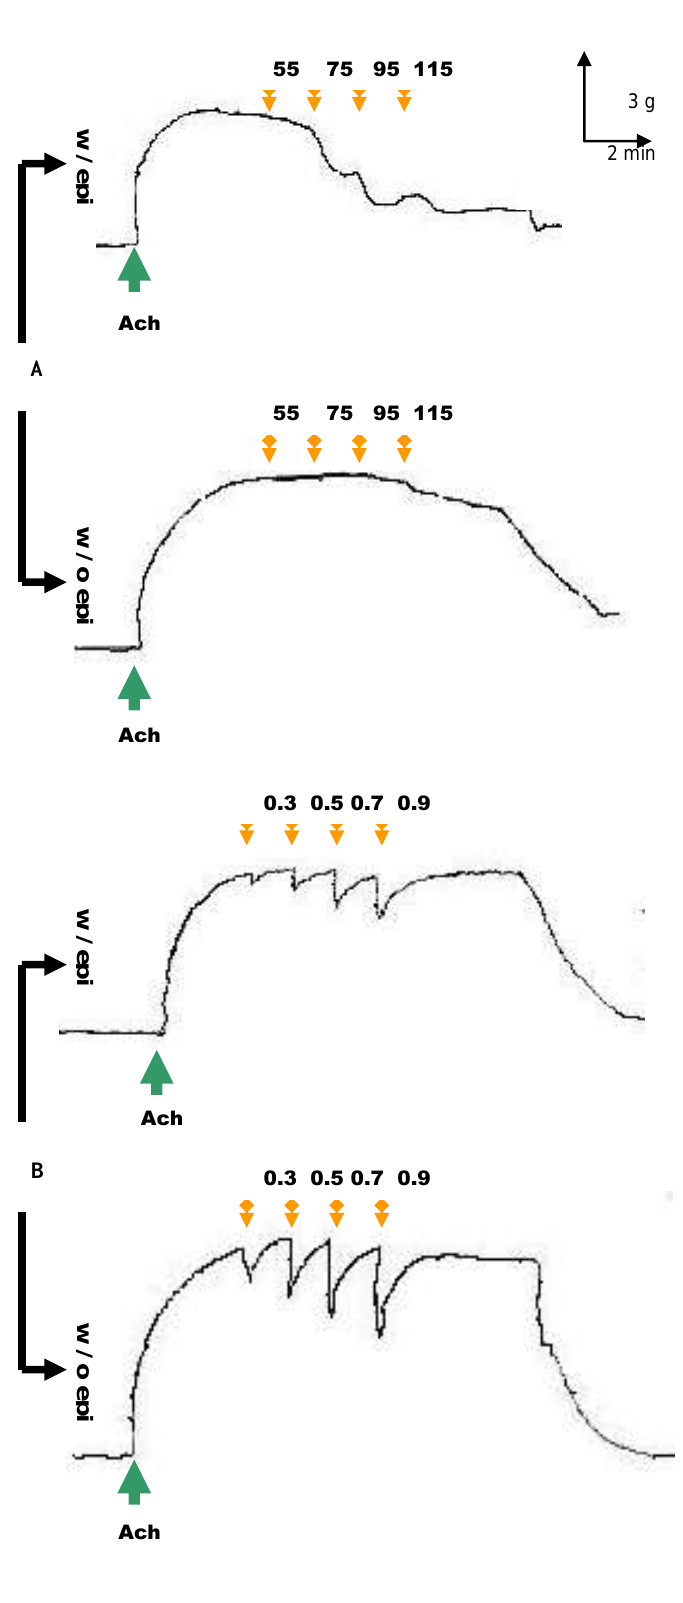
Figure 1 : Effects of Cordia myxa extract treatment on tracheal smooth muscle relaxation of sheep. Acetylcholine (Ach) - induced precontraction in a sheep trachea, which had been incubated in normal Krebs solution with epithelium (w / epi) and denuded epithelium (w / o epi). A. The tracing of theophylline (numbers indicate log micromolar concentration)-induced relaxation in w/epi and w/o epi preparations. since B . The tracing of Cordia myxa extract - induced relaxation in which the numbers indicate Cordia myxa extract treated concentration in w/ epi and w/o epi